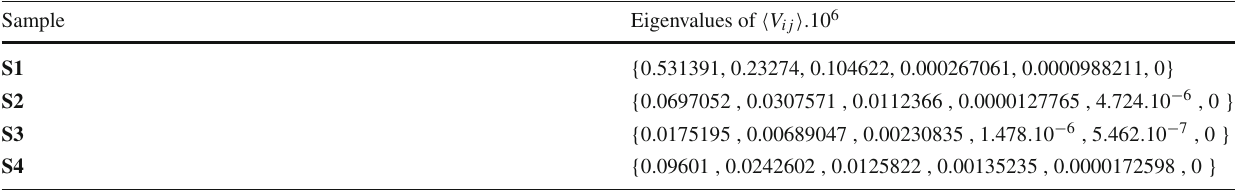
Table 4 Hessian Eigenvalues for the Minkowskian solution, i.e. (cid:10) V 0 (cid:11) = 0 corresponding to the flux samplings of Table 3. This shows that there are no tachyons present, though there is an axionic combination still remaining flat Sample